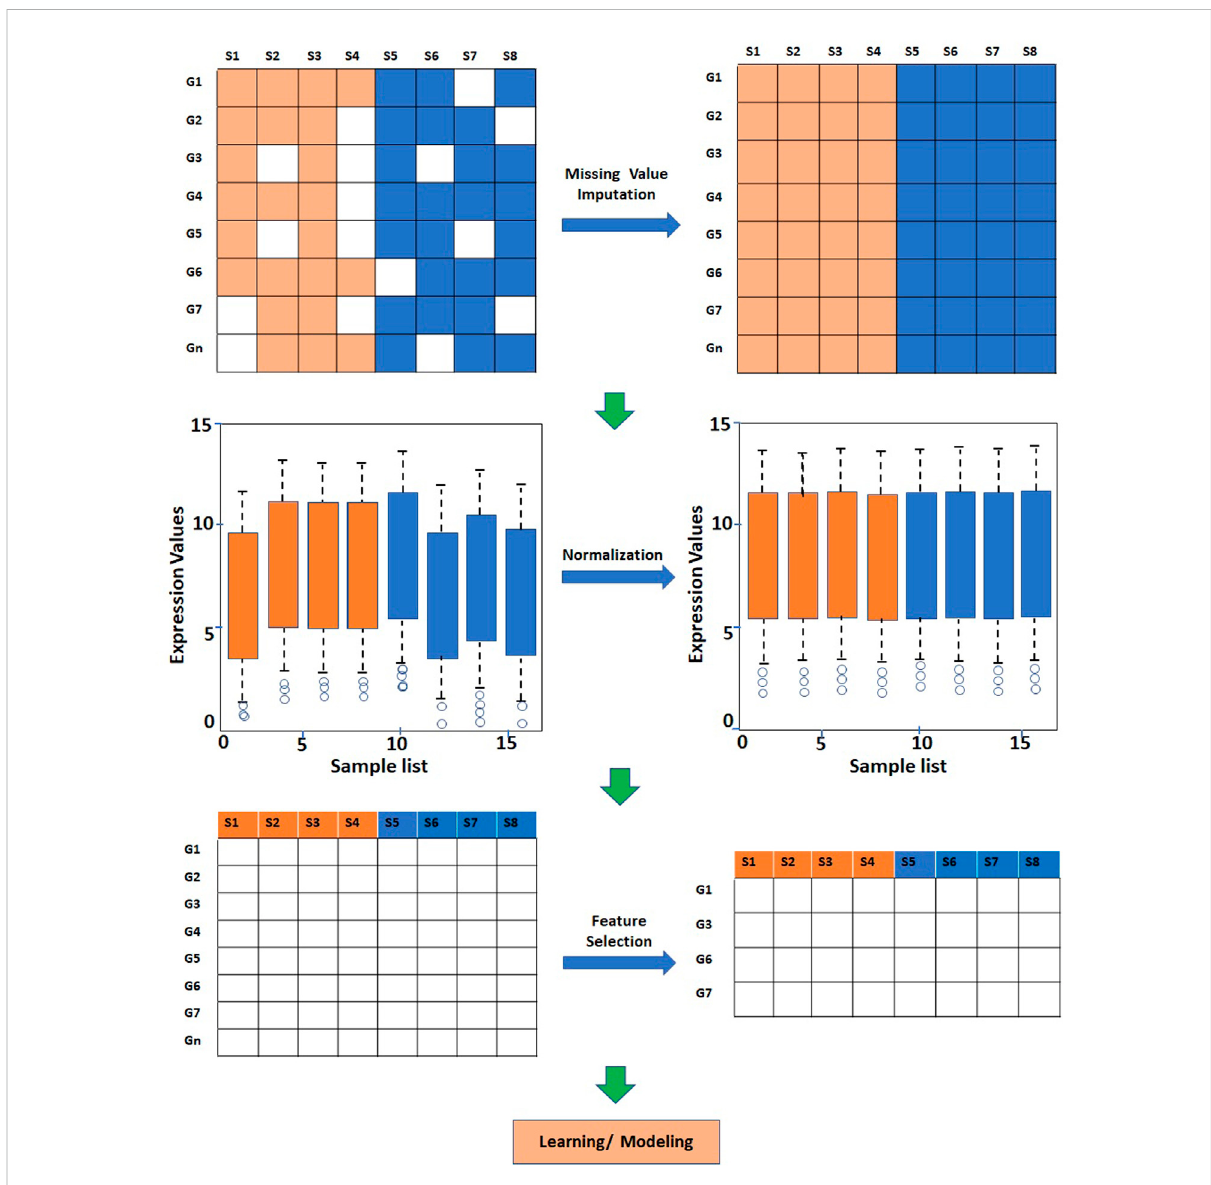
FIGURE 2 Steps involved in preprocessing and analysis of gene expression data. The raw gene expression data may get subjected to missing value imputation, normalization, and feature reduction depending on the type of